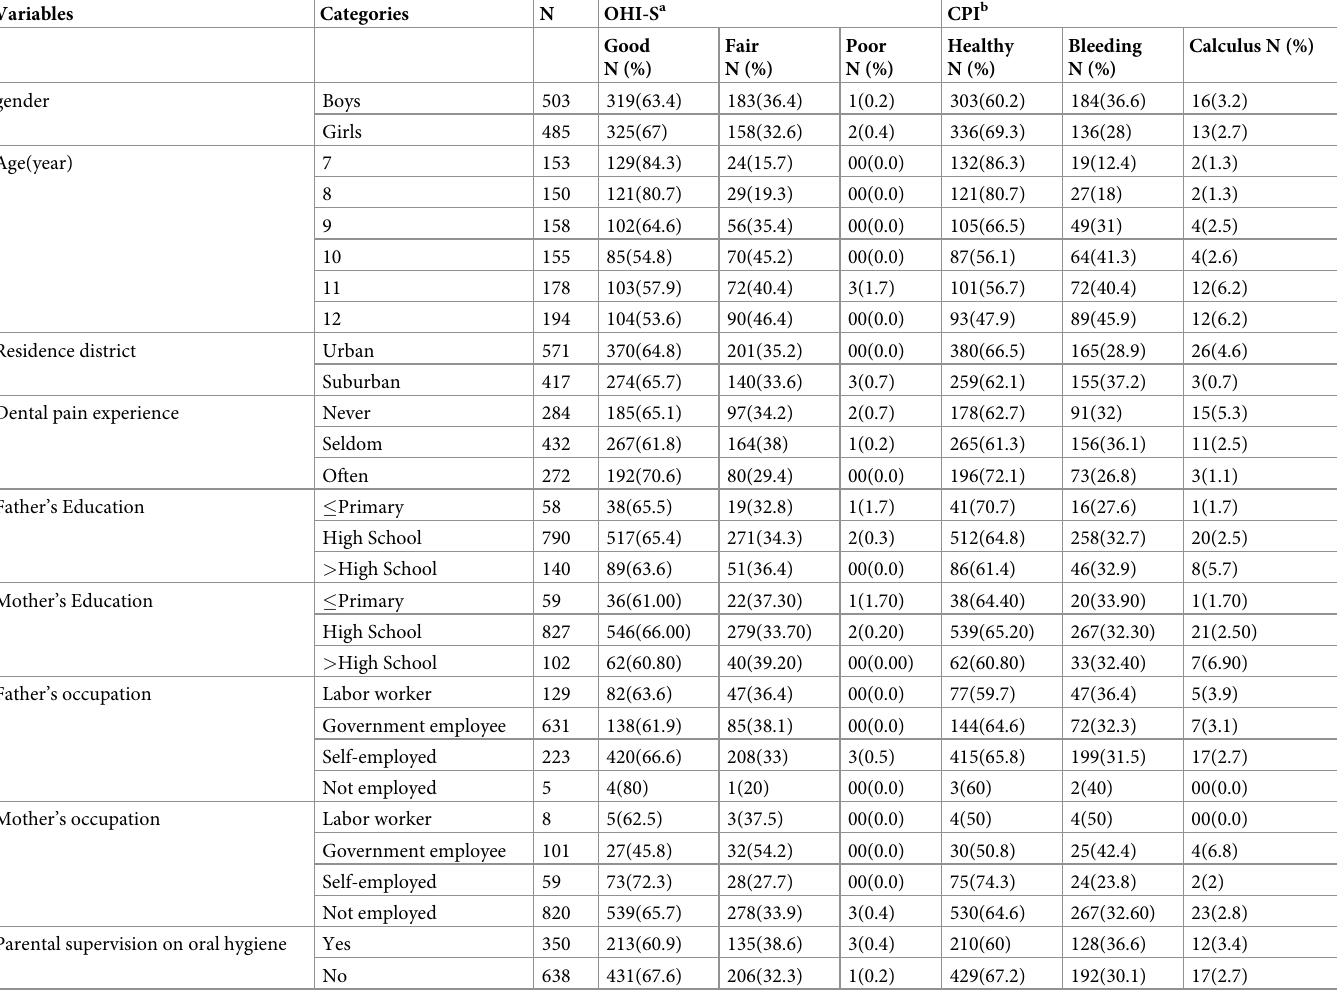
Table 1. Distribution of OHI-S and CPI indexes among student’s according to socio-demographic